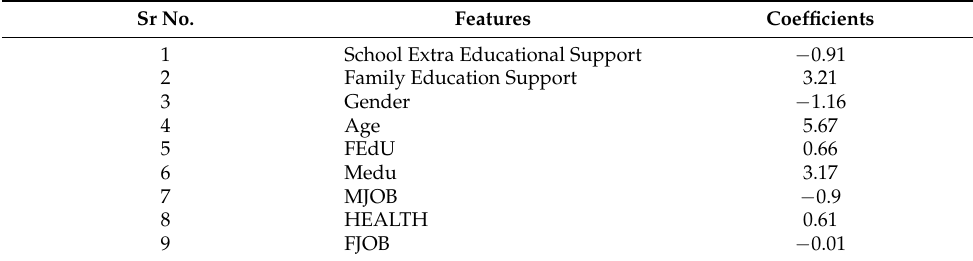
Table 9. Multiple Linear Regression Intercept and